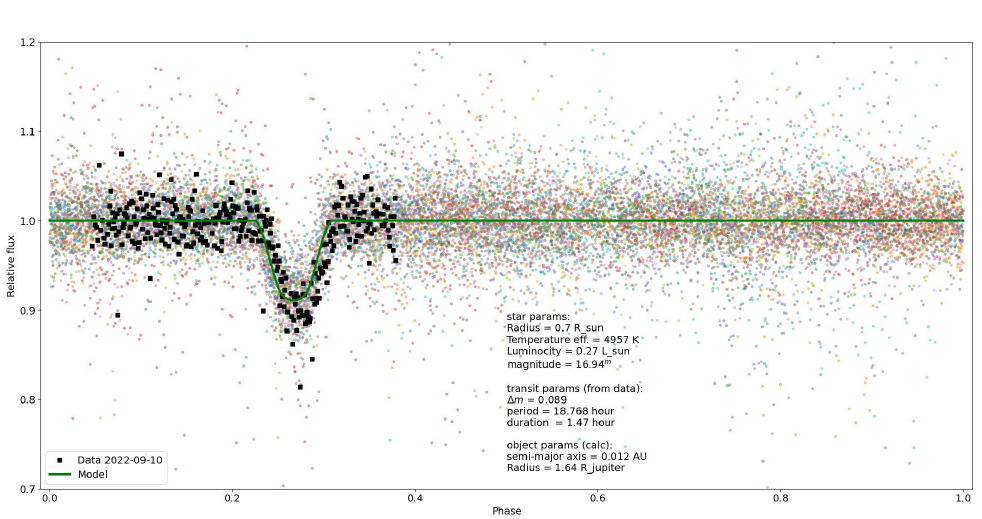
Figure 9. An exoplanet candidate detected within the Explanation